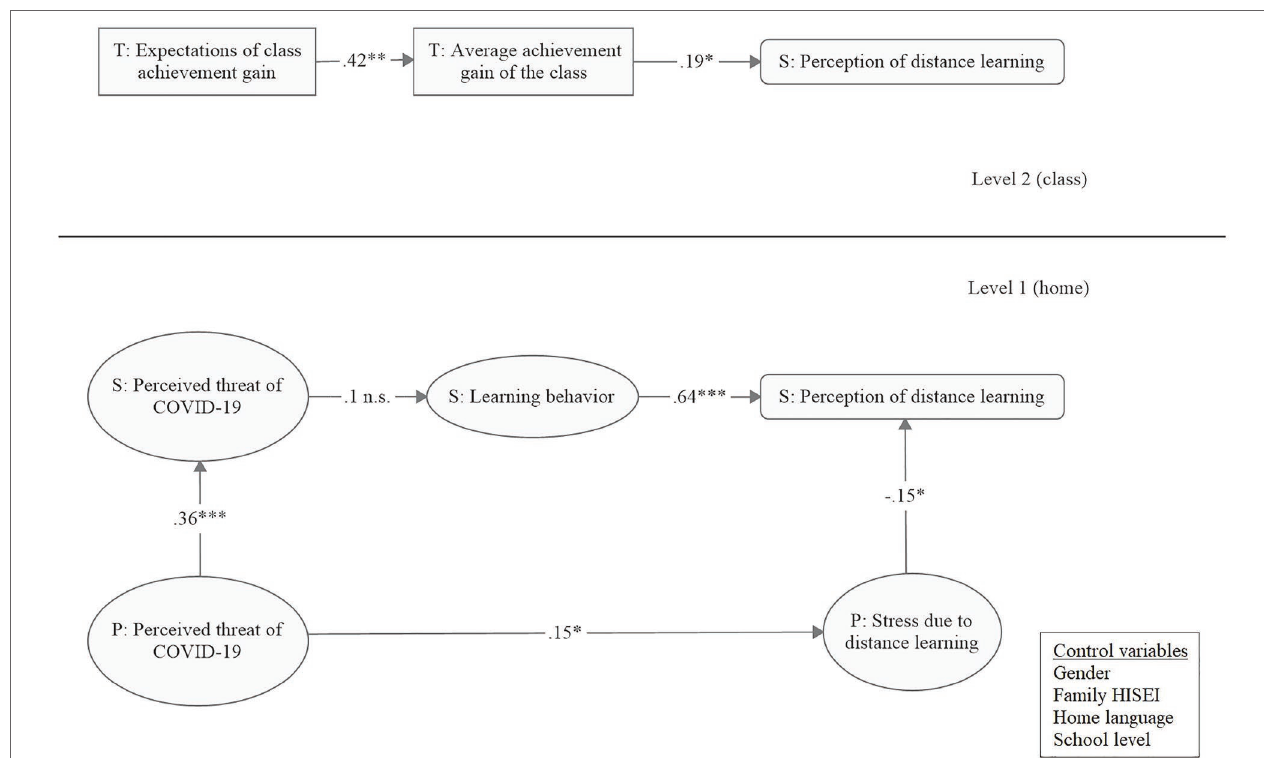
FIGURE 1 | Path diagram of the hypothesized model. S = student, P = parent, T = teacher; standardized coefficients. * p < 0.05 (two-tailed), ** p < 0.01 (two-tailed), *** p < 0.001